Question: What does this figure show? Answer in one sentence.
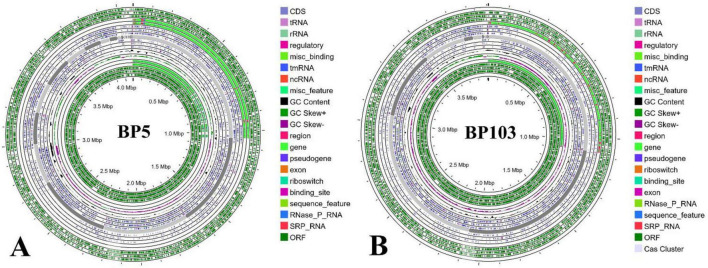
Answer: Circular genome maps of Bacillus velezensis strains BP5 (A) and BP103 (B) . The outer rings show the distribution of predicted coding sequences (CDSs) on the forward and reverse strands, while RNA genes (tRNA, rRNA, tmRNA, and ncRNA) and other annotated features are indicated by different colors as shown in the legend. The genome scale (Mbp) is displayed around the map. Genome maps were generated using the Proksee.